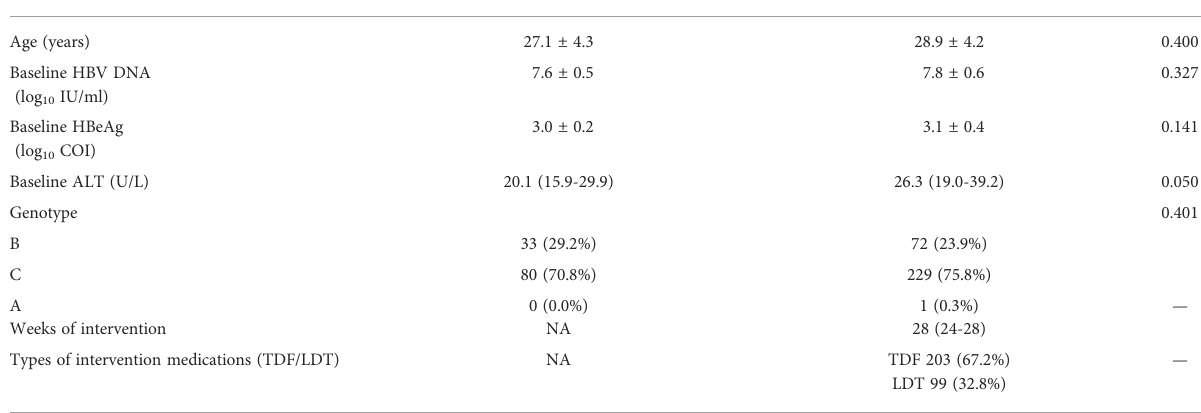
TABLE 1 General information of the two groups. General information a